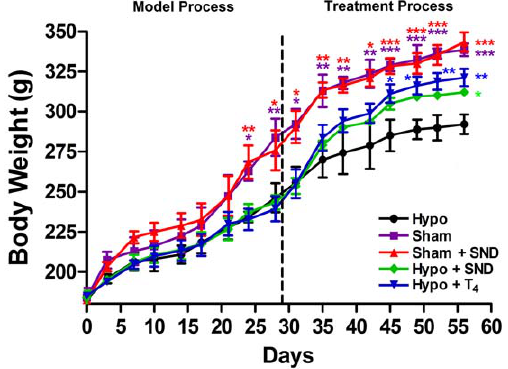
Figure 1. The Body Weight (BW) profiles during the model and treatment periods. (box represents Sham group, triangle represents Sham + SND group, dot represents Hypo group, diamond represents Hypo + SND group, inverted triangle represents Hypo + T 4